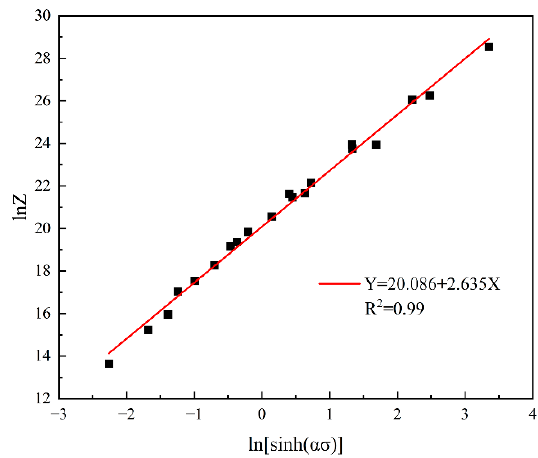
Figure 4. Based on lnZ- ln[sinh( ασ )] to solve for the parameters A.